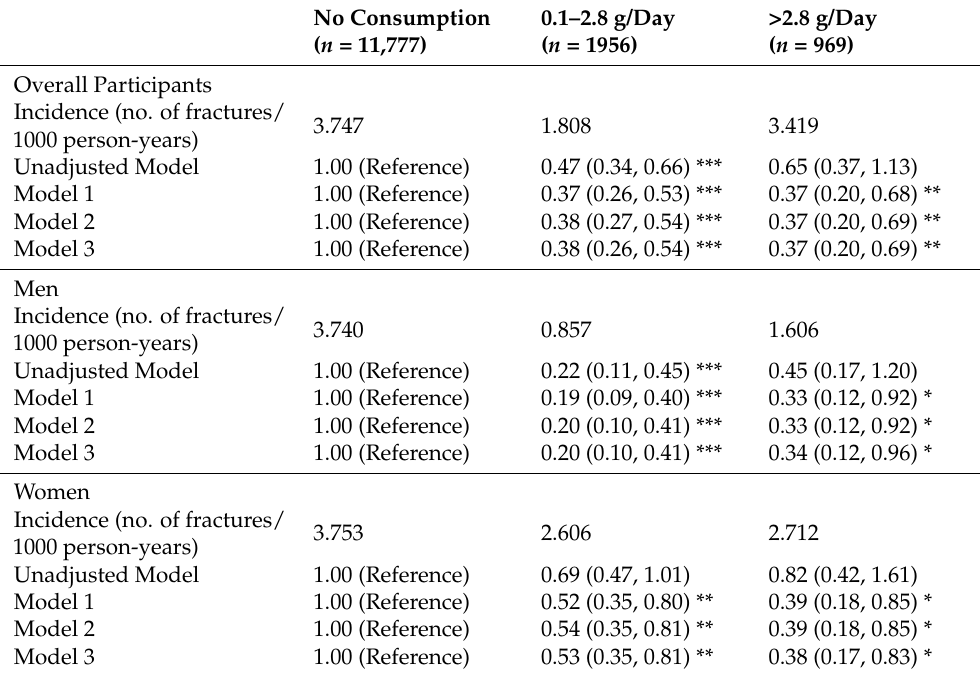
Table 4. Associations between protein in dairy product intake and the risk of